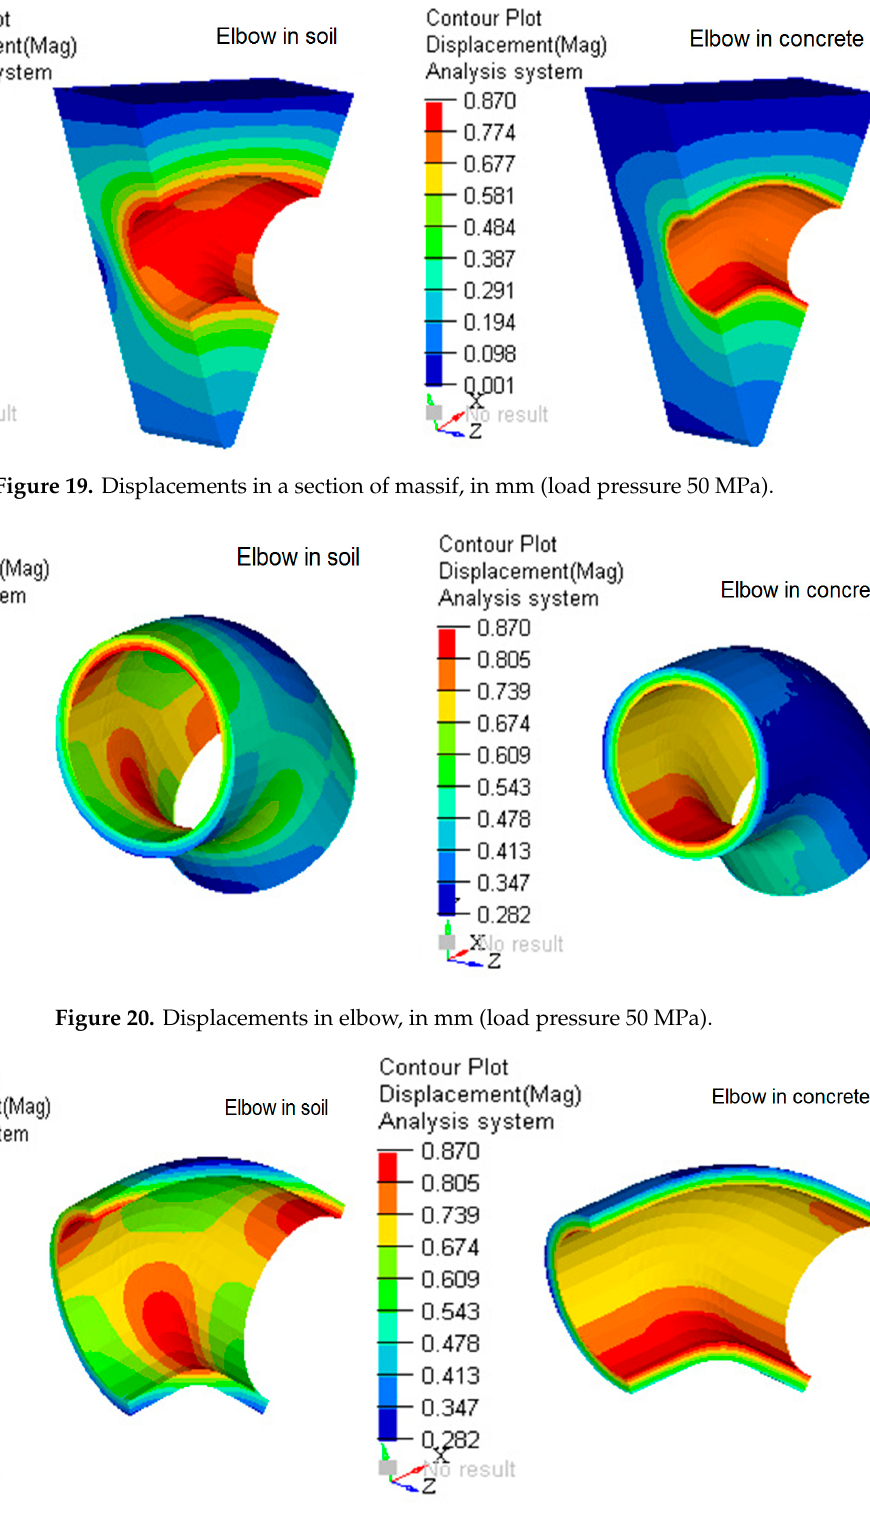
Figure 22. Pressure on the outer surface of elbow, in MPa (load pressure 50 MPa).